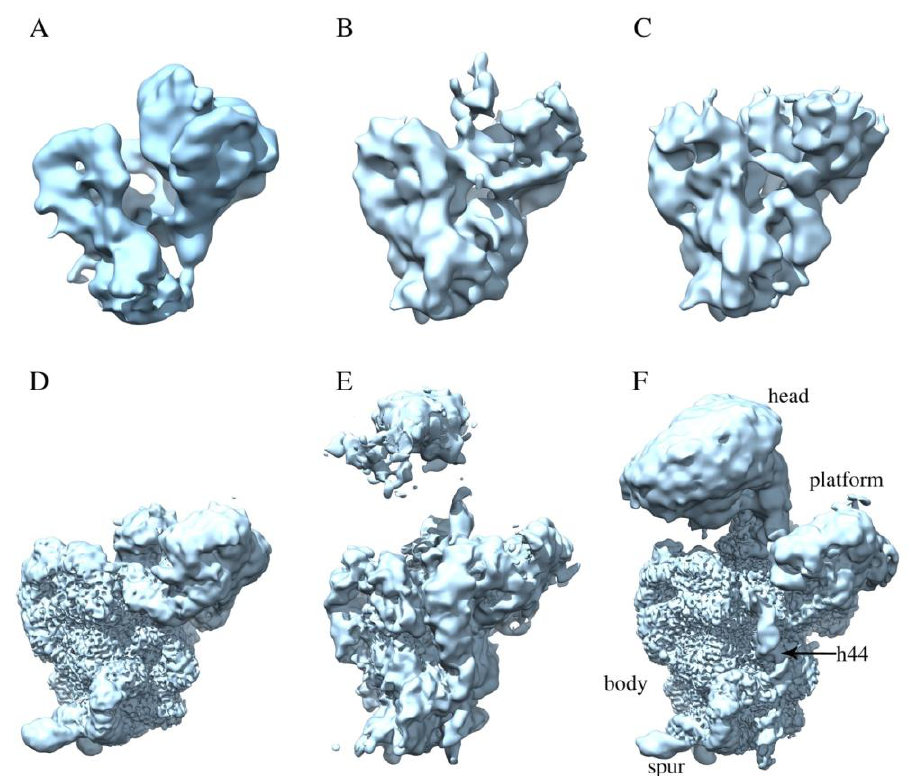
Figure 2. The sequence of intermediates on the pathway for the 30S subunit assembly. Cryo-EM maps for six classes of immature 30S particles accumulating in the ∆ rbfA strain ( A – F ), representing 8, 5, 5, 30, 12, and 39% of the particle population, respectively. The average resolution of electron density maps obtained for classes ( A – C ) and ( E ) was limited to 8 Å. The cryo-EM structures for the two most common classes ( D , F ) were determined at a 2.7 Å